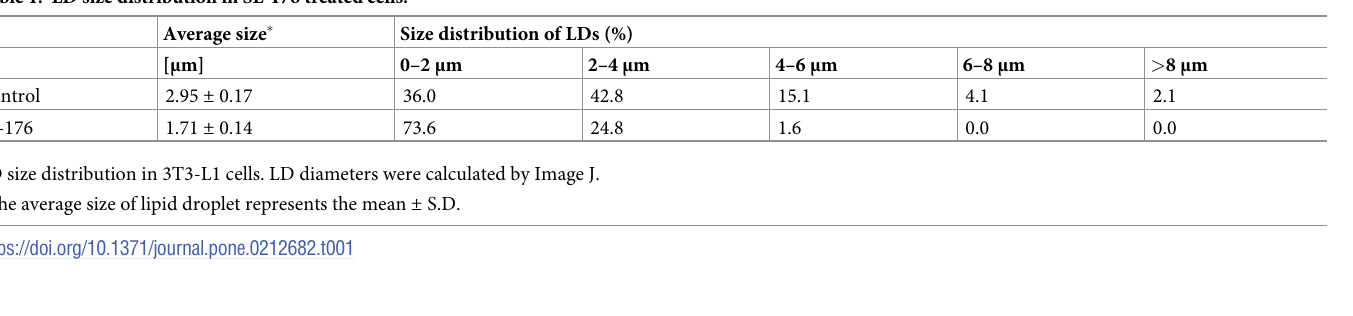
Table 1. LD size distribution in SL-176 treated cells.